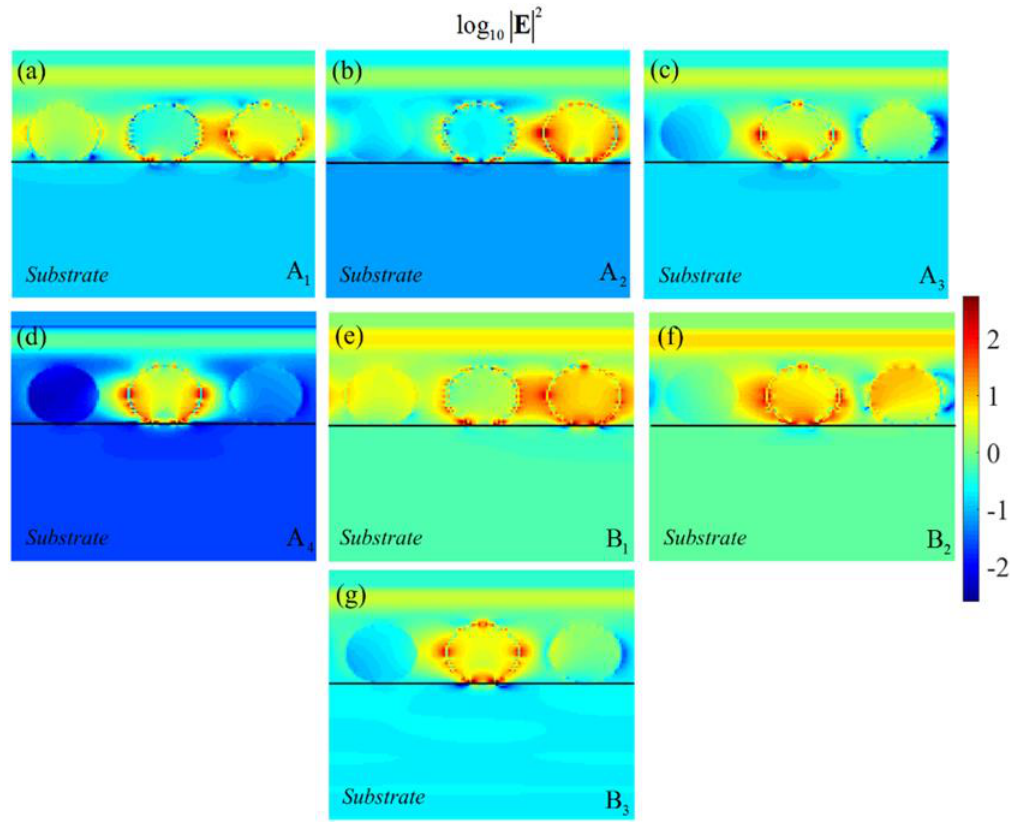
Figure 7. Electric field intensity in logarithmic scale for the periodic trimer array metasurface composed of doped SiC nano-spheres with the doping concentration of n 1 = 1 × 10 18 , n 2 = 2 × 10 19 , and n 3 = 4 × 10 19 ( cm − 3 ) at ( a – d ) the higher reflective modes of A 1 , A 2 , A 3 , A 4 ; and ( e – g ) the lower reflective modes of B 1 , B 2 , and B 3 , respectively.